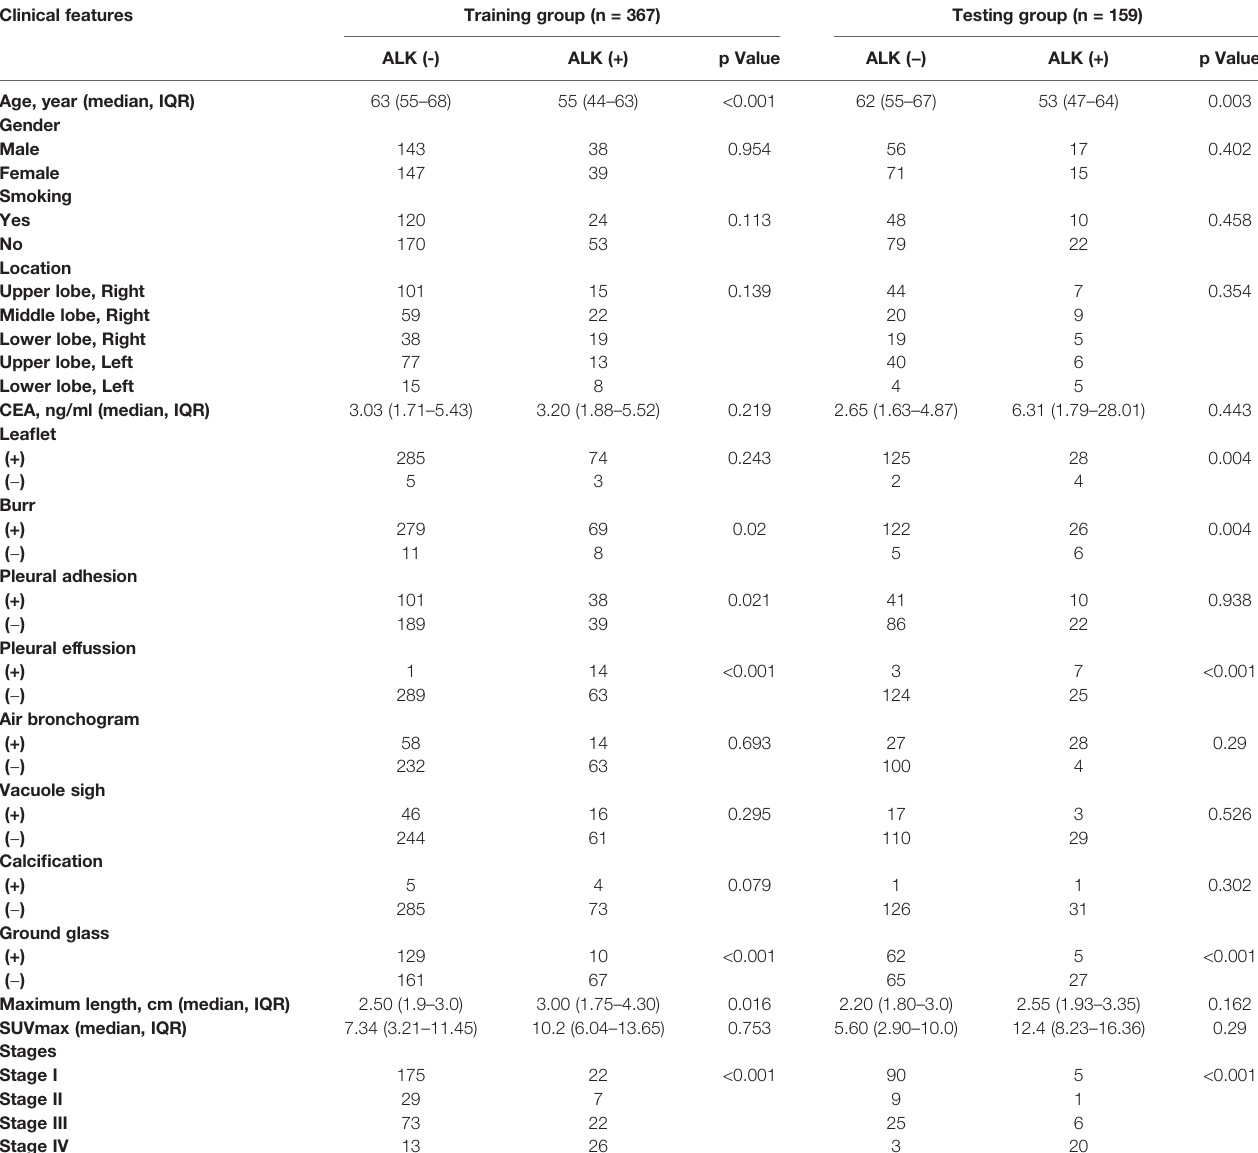
TABLE 1 | Clinical features of 526 patients enrolled in this study. Clinical